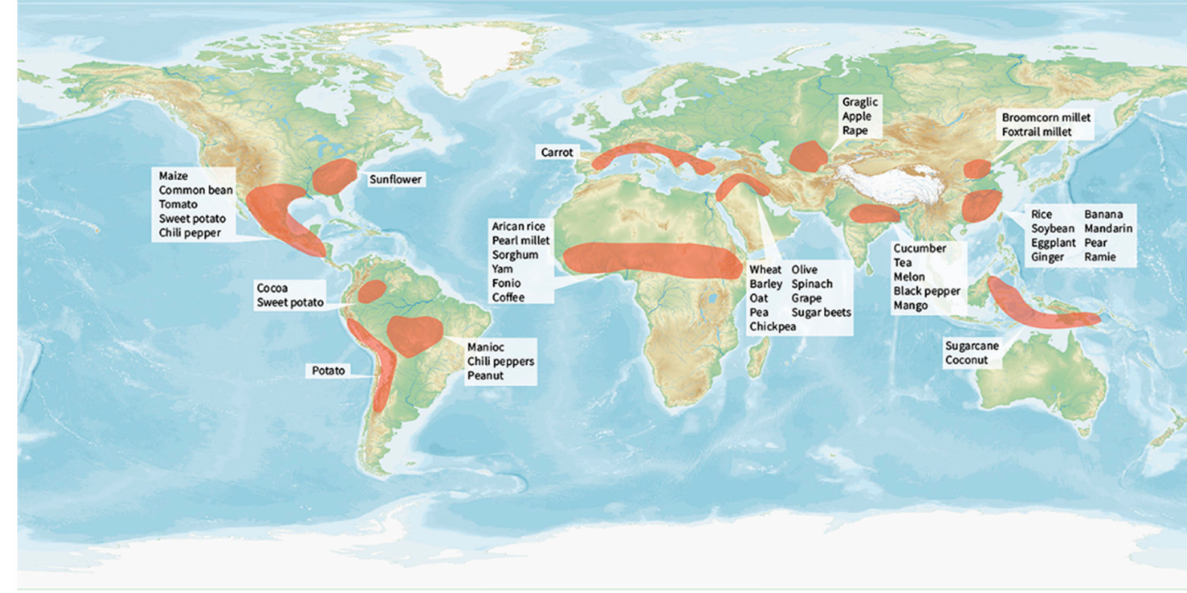
Figure 1. Global food crop origin and domestication. Shaded regions indicate approximate locations of centers of crop origin and